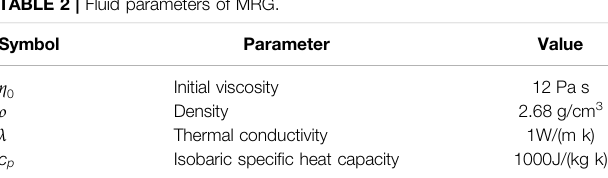
TABLE 2 | Fluid parameters of MRG.